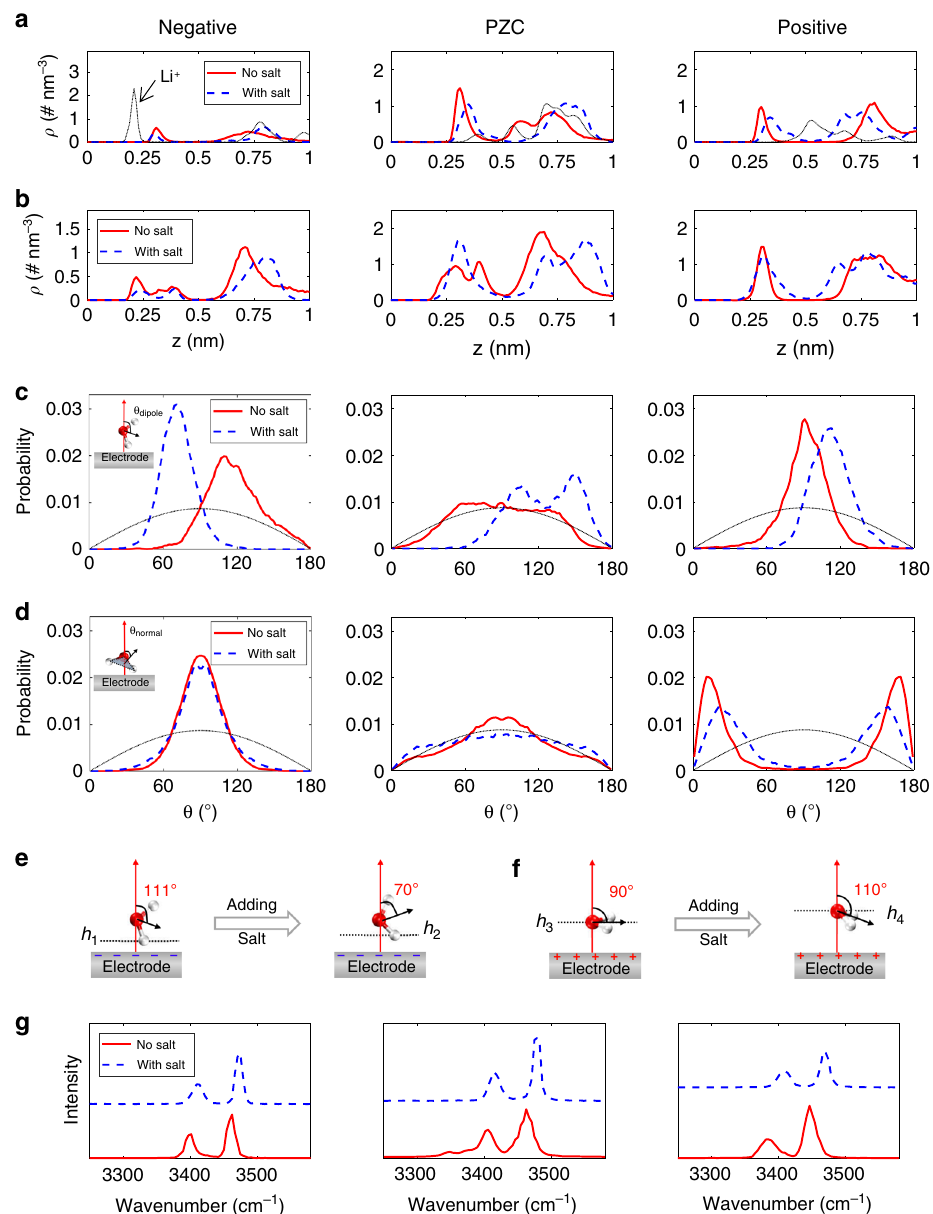
Fig. 5 Effect of adding salt on the structure of interfacial water in humid ionic liquids. a The oxygen atom number densities ( ρ ) of water in humid ionic liquid (IL) (red solid line), and in salt-in-humid IL (blue dash line) at electrodes. The black dotted line is the atom number density of Li + in salt-in-humid IL. b The hydrogen atom number densities of water in humid IL and in salt-in-humid IL at electrodes. c , d The dipole ( c ) and normal ( d ) orientations of interfacial water in humid IL (red solid lines) and in salt-in-humid IL (blue dash lines) at electrodes. θ dipole is de fi ned as the angle between the normal of the electrode surface and the water vector, and θ normal is the angle formed between the normal of the electrode surface and the normal of water plane. The black dotted line represents the orientation of bulk water. e , f Schematics of arrangement change of interfacial water under negative ( e ) and positive ( f ) polarizations in humid IL due to adding salt. g Infrared spectroscopy (IR) spectra of interfacial water in humid IL and in salt-in-humid IL. The electrical double-layer (EDL) potentials are − 2 V and 1 V for negative and positive electrodes,